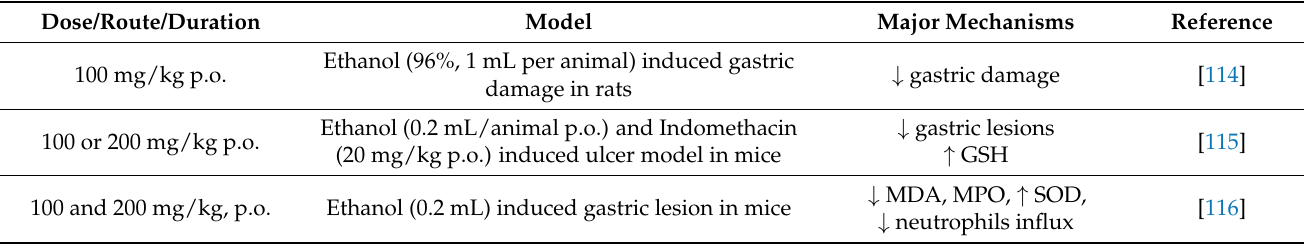
Table 9. Effects of α -Bisabolol in preclinical models of gastrointestinal diseases. Dose/Route/Duration